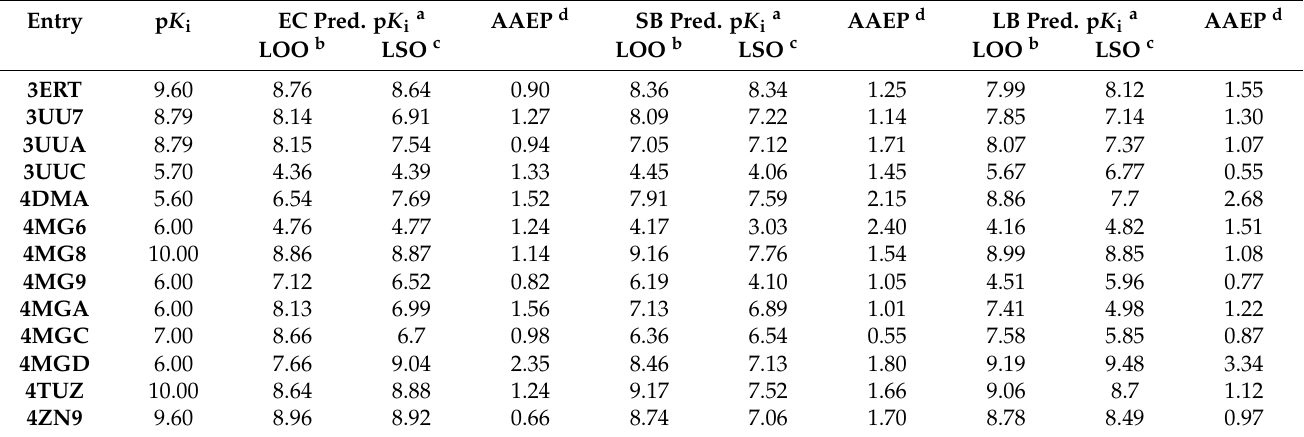
Table 5. Summary of the 3-D PhypI/3-D QSAR model ensemble experimental/structure- based/ligand-based predictive ability for TS CRY .